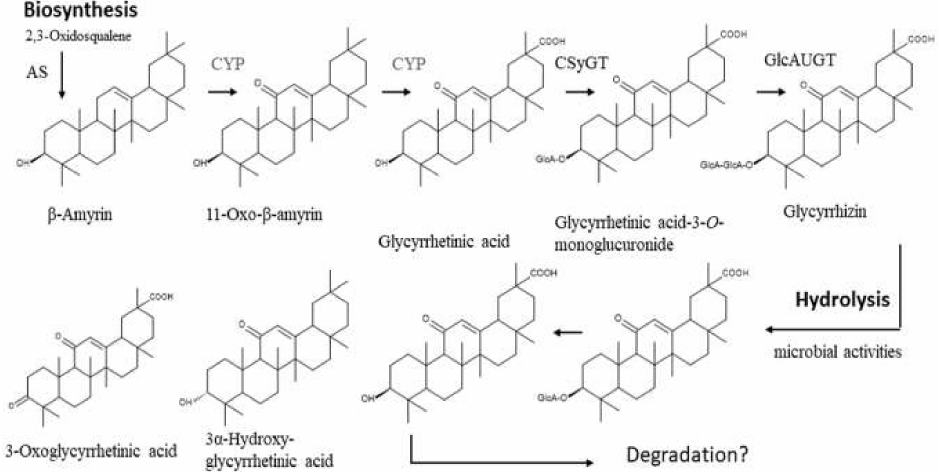
Figure 7. Biosynthesis of glycyrrhizin in Glycyrrhiza spec. and hydrolysis of glycyrrhizin to aglycon glycyrrhetinic acid in the human gut